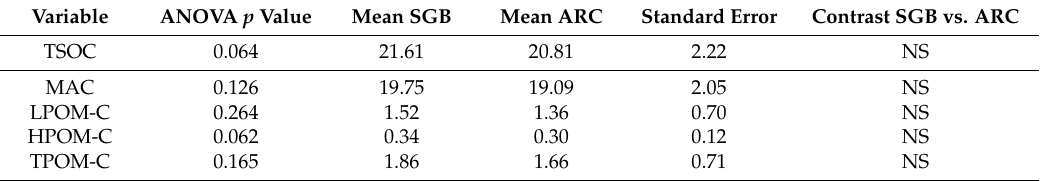
Table 3. ANOVA results from a comparison of the concentration of carbon associated with soil organic matter fractions from switchgrass buffer (SGB) and non-buffered annual row crop